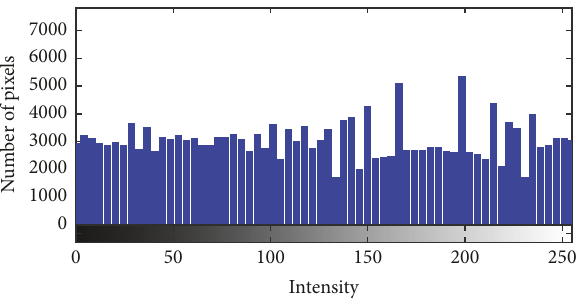
Figure 6: The equalization histogram.